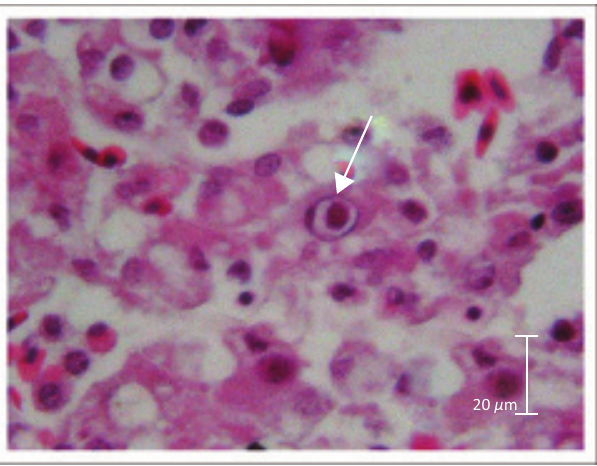
FIGURE 1: Basophilic viral inclusion body in the nucleus of a hepatocyte of one of the affected crocodile hatchlings (haematoxylin and eosin-stained section, magnification: